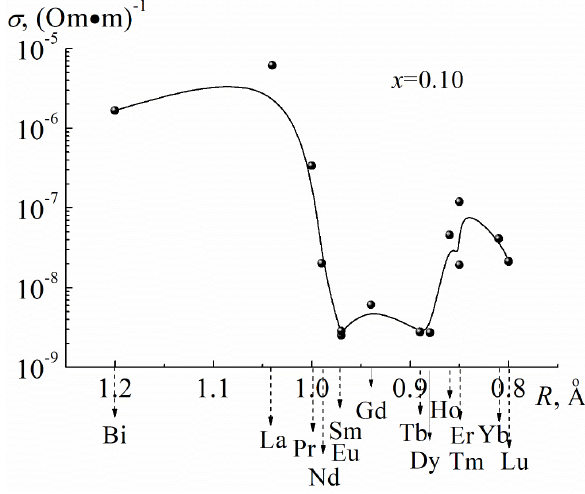
Figure 6. Dependences of the values of specific electrical conductivity σ , BiFeO 3 /REE on radii, R , REE (experimental points are marked with markers; solid lines serve as a guide to the eye).